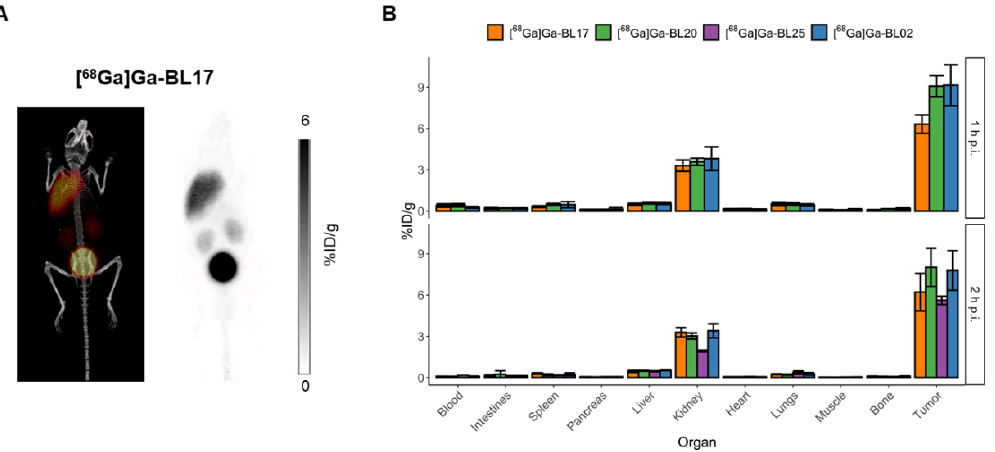
Figure 3. ( A ) Maximum intensity projections for PET/CT and PET alone at 1 h p.i. [ 68 Ga]Ga-BL17. Scales of the PET images of [ 68 Ga]Ga-BL17 are 0–6 %ID/g. ( B ) Ex vivo biodistribution data of [ 68 Ga]Ga-BL17; [ 68 Ga]Ga-BL20; and [ 68 Ga]Ga-BL25 in comparison to that of [ 68 Ga]Ga-BL02 in Daudi xenograft-bearing mice at 1 and 2 h p.i. [ 68 Ga]Ga-BL25 was only evaluated at 2 h p.i. [ 68 Ga]Ga-BL17 (Aad) maintained a similar biodistribution profile as compared to [ 68 Ga]Ga-BL02, with no differences in kidney uptake (Figure 3). However, the tumor uptake was lower (6.32 ± 0.67 and 6.40 ± 1.60 %ID/g at 1 and 2 h p.i., respectively), which was significantly lower at 1 h p.i. ( p = 0.0015) but similar at 2 h p.i. ( p = 0.1992) compared to [ 68 Ga]Ga-BL02. PET imaging with [ 68 Ga]Ga-BL17 that was performed at 1 h p.i. further